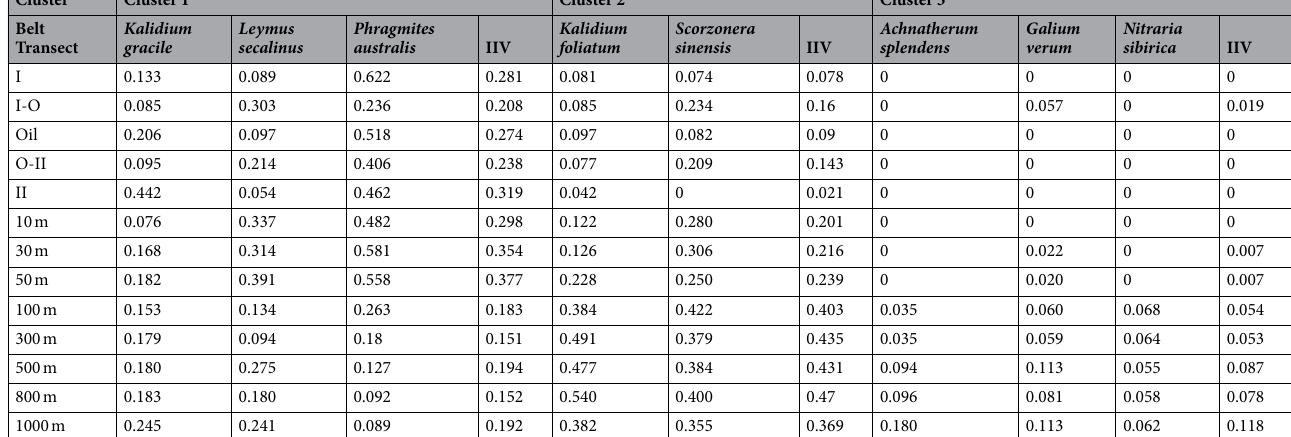
Table 1. Importance value of each species and IIV of each Cluster in the belt transects. Note: Pipeline area, the area in which pipeline was laid, encompasses belt transects I, Oil and II. I-O and O-II are the belt transects set in the middle of WEGP I and WCOP, WCOP and WEGP II, respectively. 10 m, 30 m, 50 m, 100 m, 300 m,